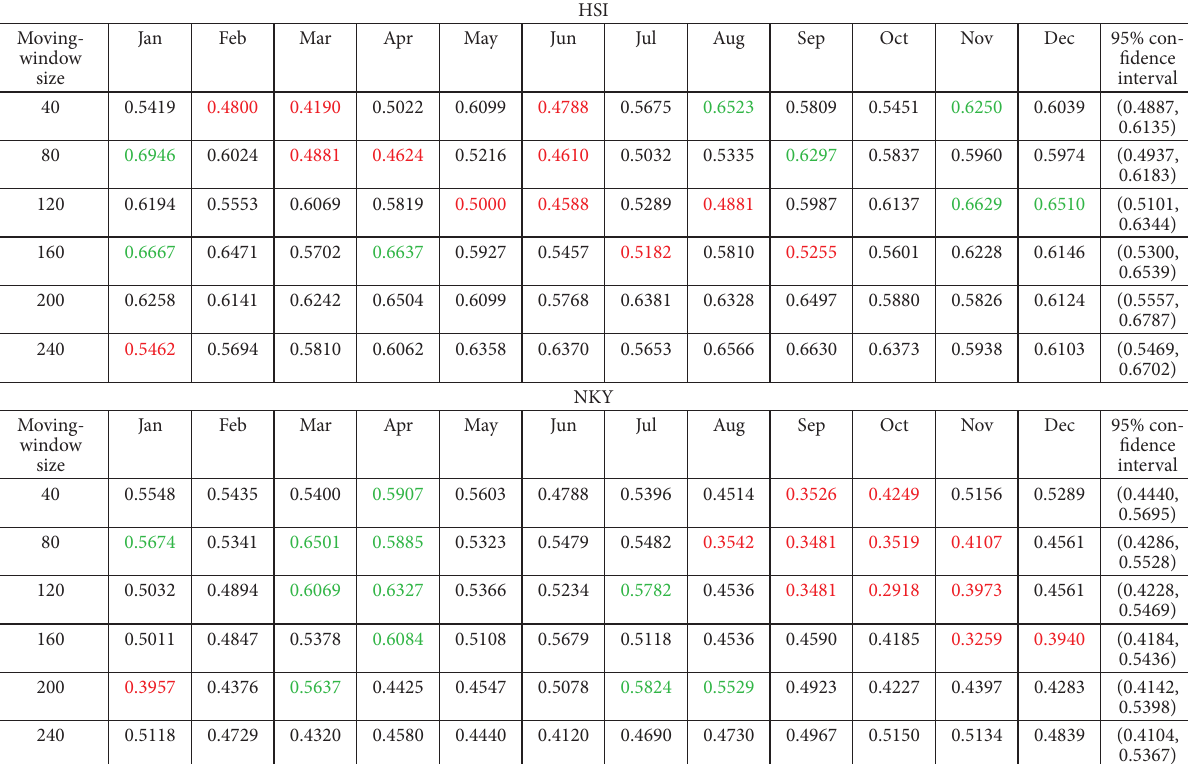
Table 6. The test results for the overall calendar effect using Method